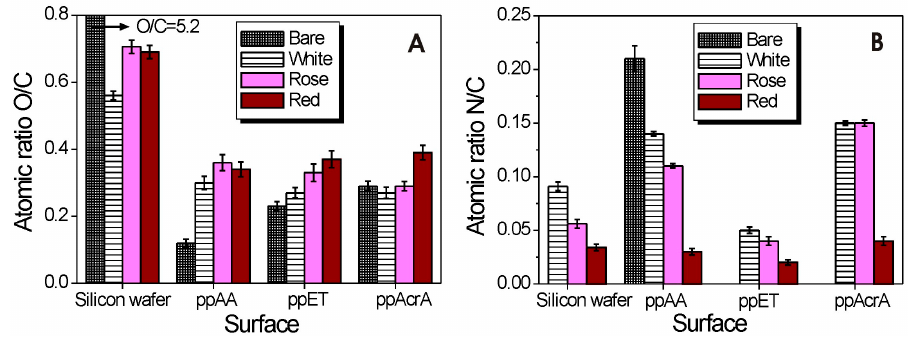
Figure 3. Surface ( A ) O/C and ( B ) N/C content of wines simply dried on a silicon wafer and after adsorption onto plasma polymerized